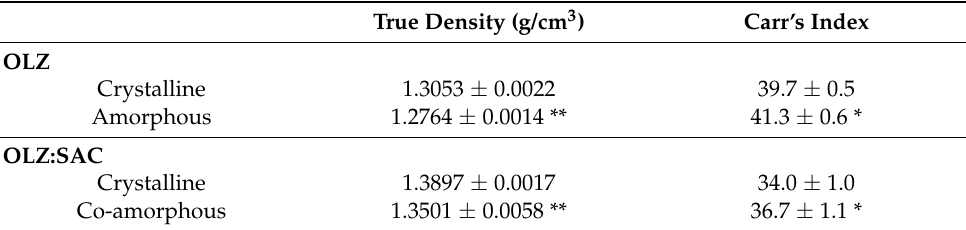
Table 3. Pycnometric density and Carr’s index of crystalline and amorphous OLZ, as pure material or in physical mixture with